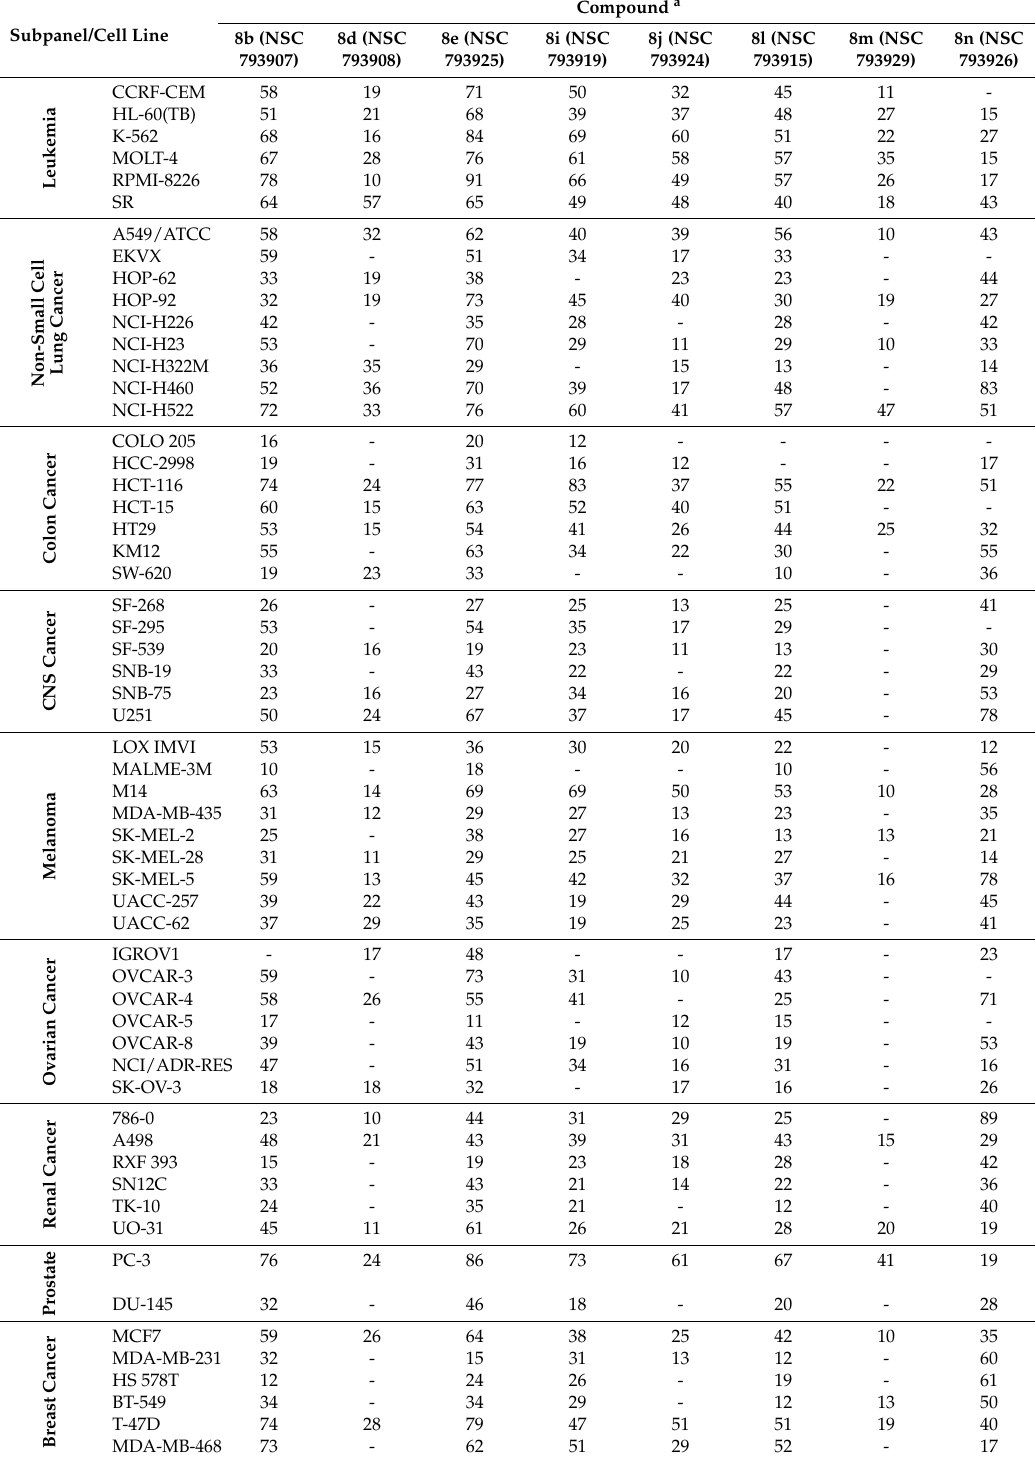
Table 2. Percentage growth inhibition (GI%) of in vitro subpanel tumor cell lines at 10 µ M concentration for compounds 8b , 8d , 8e , 8i , 8j and 8l – n